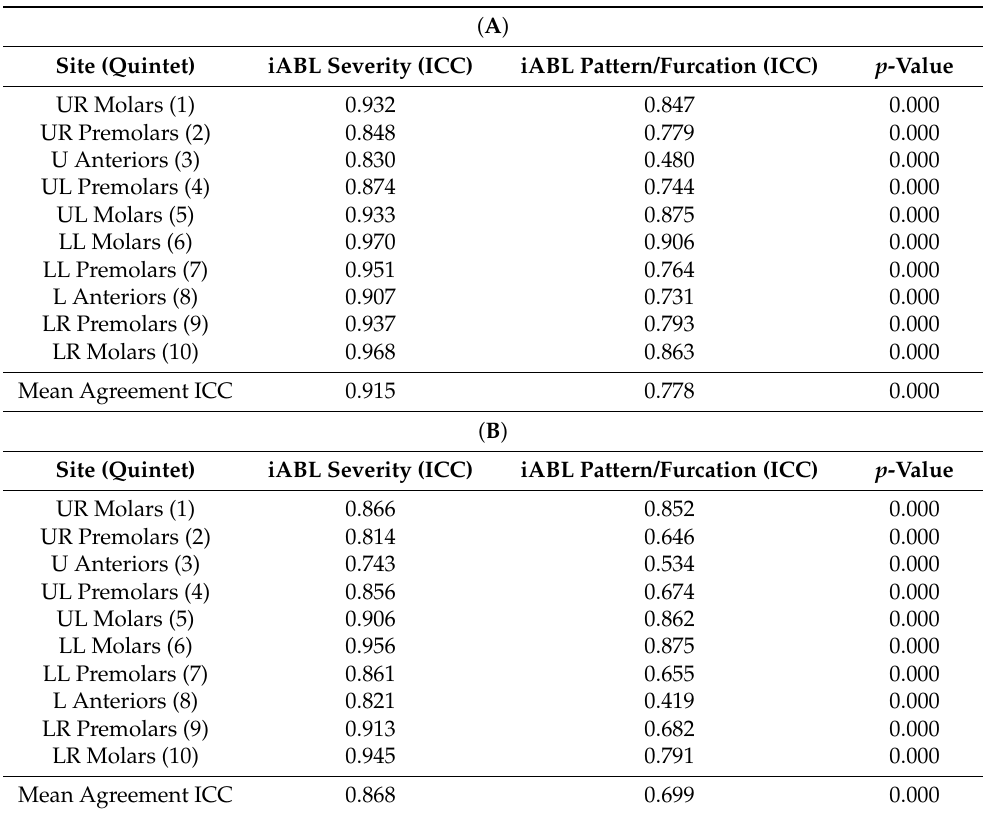
Table 4. ( A ) . Inter-examiner agreement scores (postgraduate students (PGTs) and consultants in